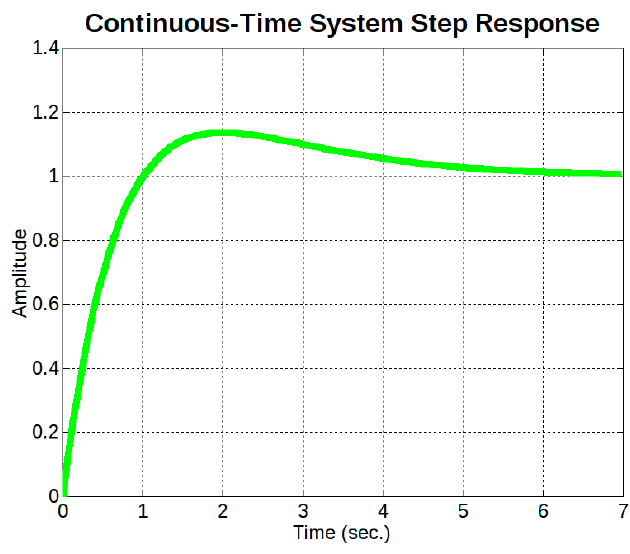
Figure 21. Step response of the analog system described by Equation (77). Figure 21 . Step response of the analog system described by Equation (77). Figure 21 . Step response of the analog system described by Equation (77).